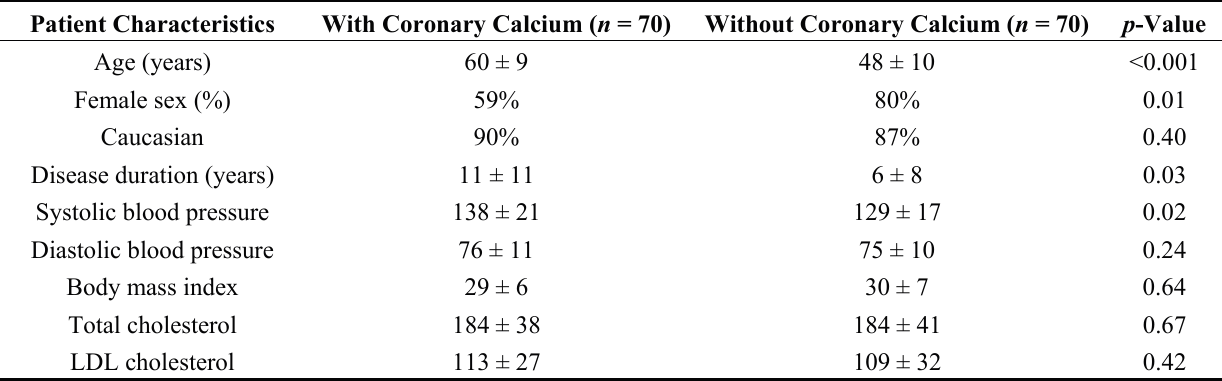
Table 1. Clinical characteristics of patients with rheumatoid arthritis with and without coronary